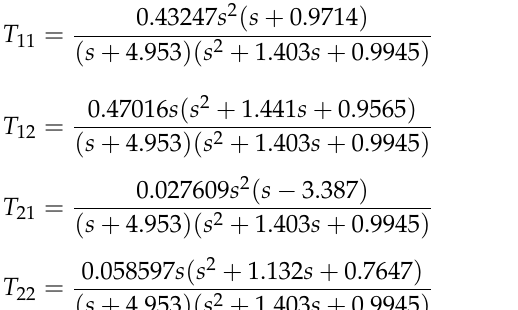
T . Figure 28b indicates that the influence 21